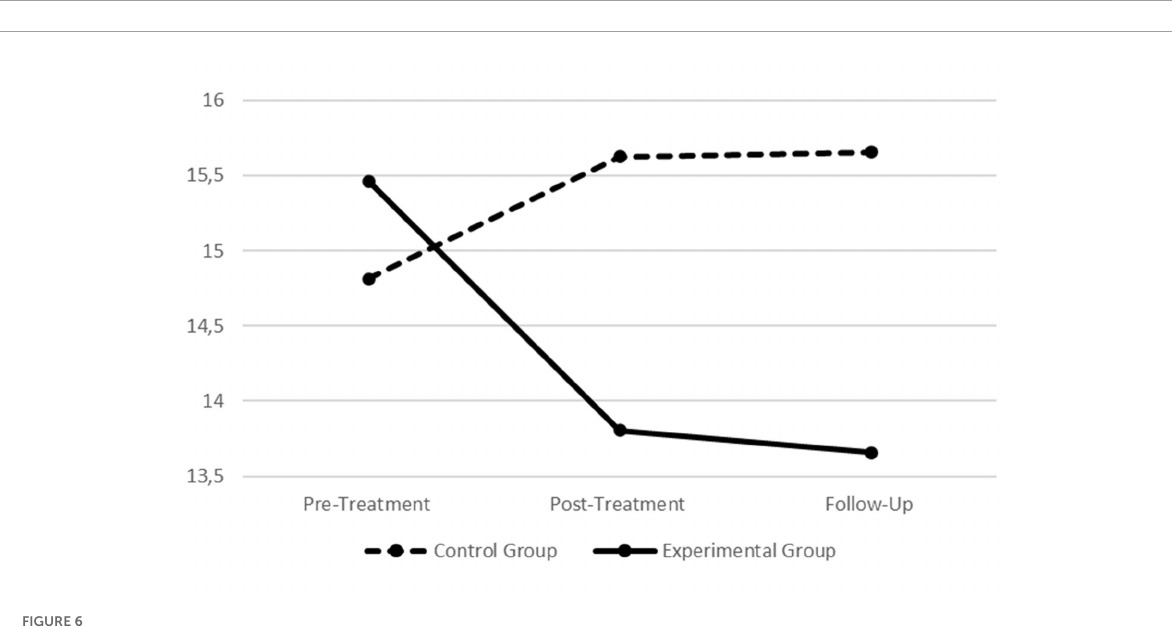
as the ones displayed by young offenders with psychopathic traits (9,